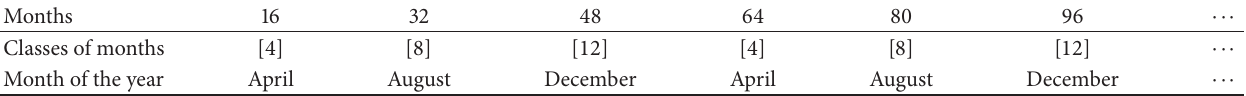
Table 1: First multiple of 16 months and their respective congruence classes